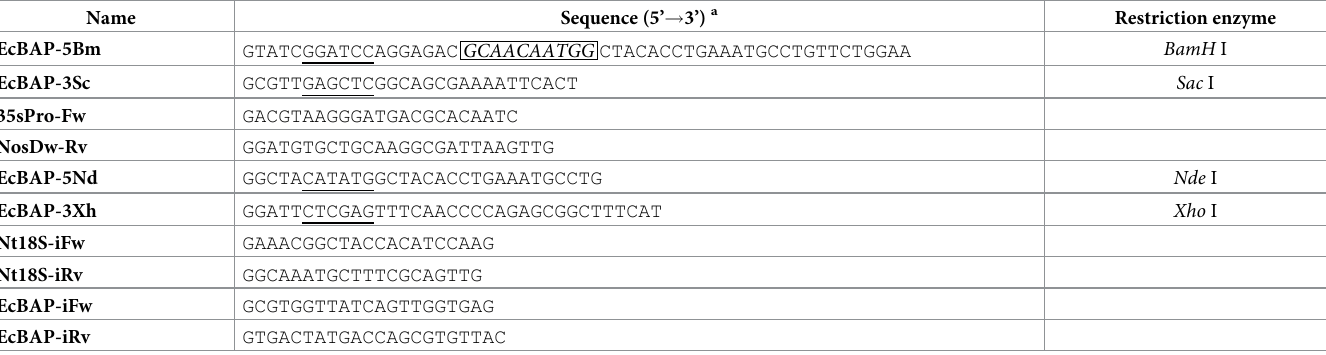
Table 1. Primers used in this